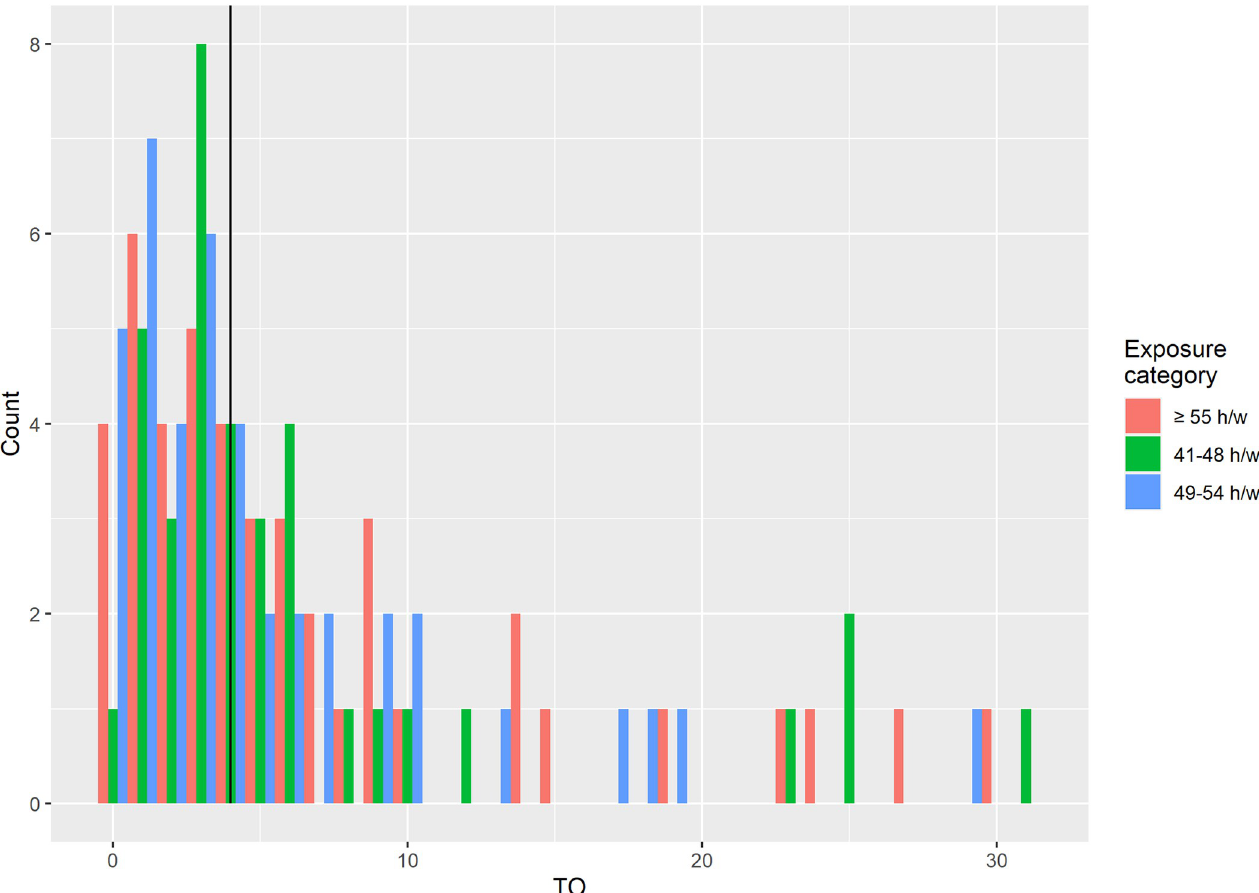
Fig 4. Histogram of the prevalence of exposure to � 55 h/w in 2016 relative to the prevalence of exposure to � 55 h/w over the period of 2002–2011. Vertical line at 4 indicates the generally accepted OT = 4 for short latency diseases. It is important to note that a single multiplication factor cannot describe all cohorts and exposure categories